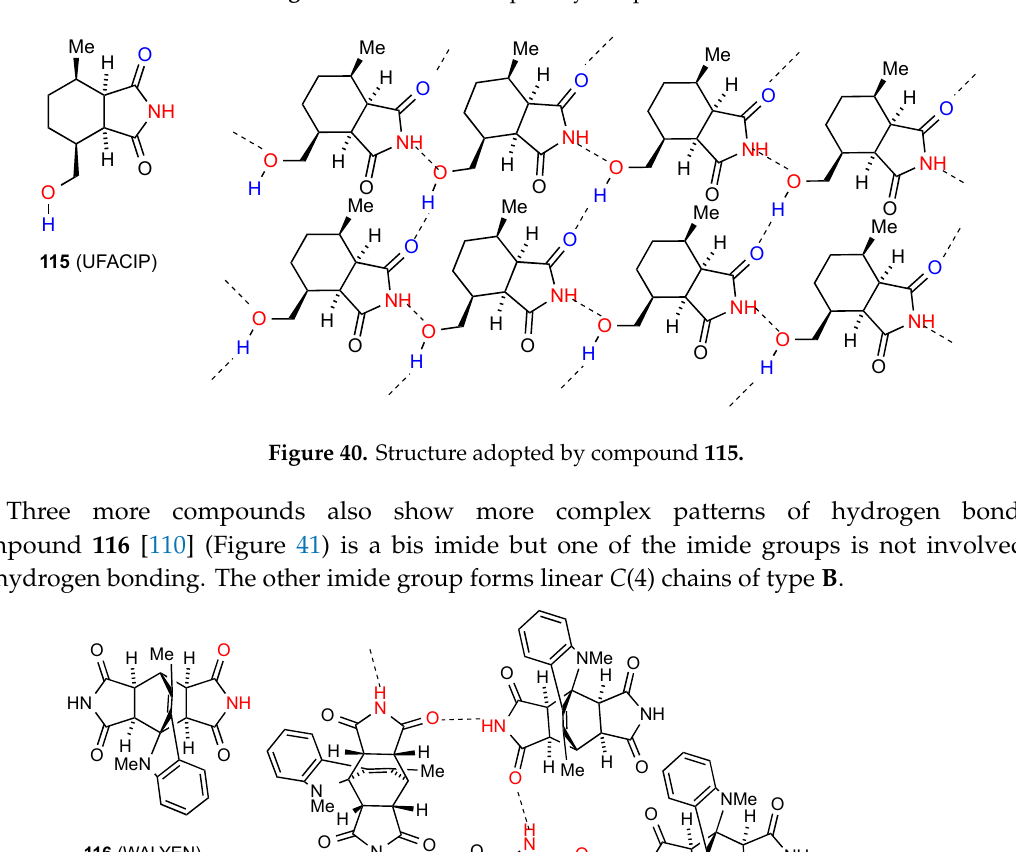
Figure 39. Structure adopted by compound 114.